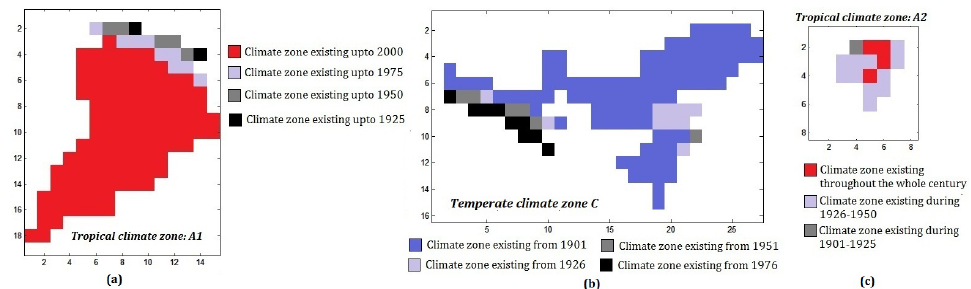
Figure 10. Spatio-temporal change in climate zones during 20th century: (a) Tropical climate zone (A1) in Eastern India , (b) Temperate zone (C) , (c) Tropical climate zone (A2) in North-Eastern India